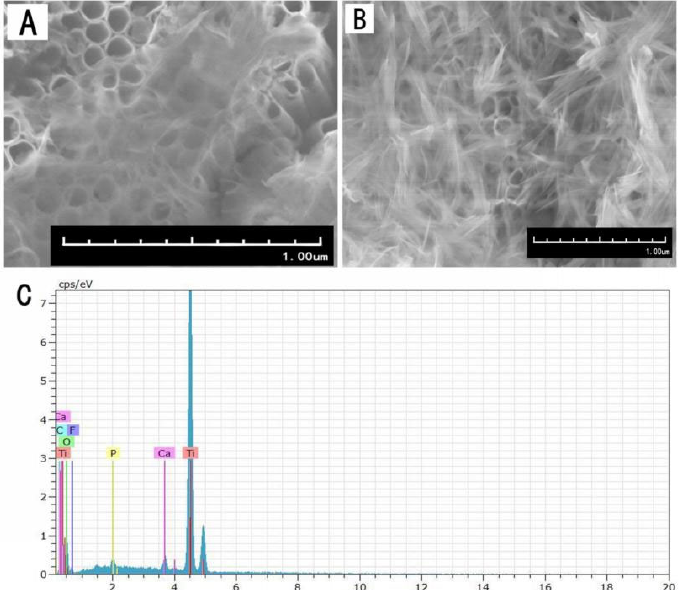
Figure 2. Scanning electron microscope images and EDX analysis of anodized titanium coated with gentamicin and in simulated body fluid. ( A , B )show the TNT samples soaked in SBF for 24 h and 72 h. ( C ) shows EDX analysis of the coating that uncovered the presence of P and Ca in the coating placed onto the anodized titanium surface. Scale bars = 200